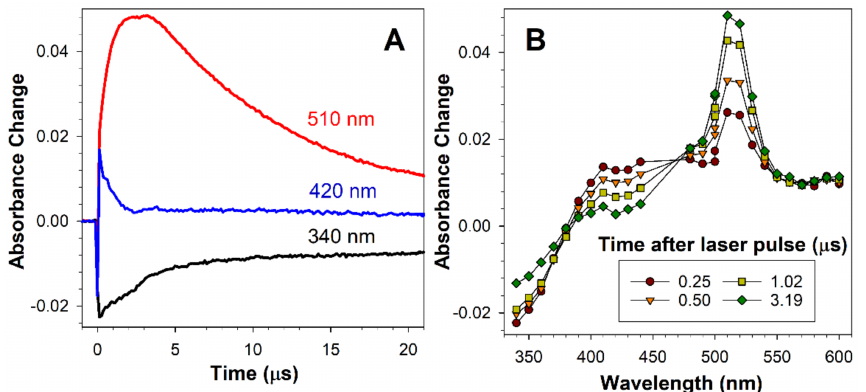
Figure 3. The transient species formed after photoexcitation of DHE transfers is an excited triplet state. Representative kinetics ( A ) and absorption spectra of a transient species generated at indicated times after photoexcitation of oxidised DHE with a 5 ns laser pulse of 355 nm wavelength in argon-saturated acetone in the presence of zeaxanthin ( B ). The lifetime of 420-nm-absorbing species is shortened in the presence of zeaxanthin, in comparison with its lifetime in the absence of zeaxanthin, shown in Figure 2B, and decays with concomitant formation of zeaxanthin triplet state with a maximum at 510–520 nm. Zeaxanthin contributes to the absorption of light at 340 nm, which results in more complex kinetics of the recovery of the ground-states than in the absence of zeaxanthin.